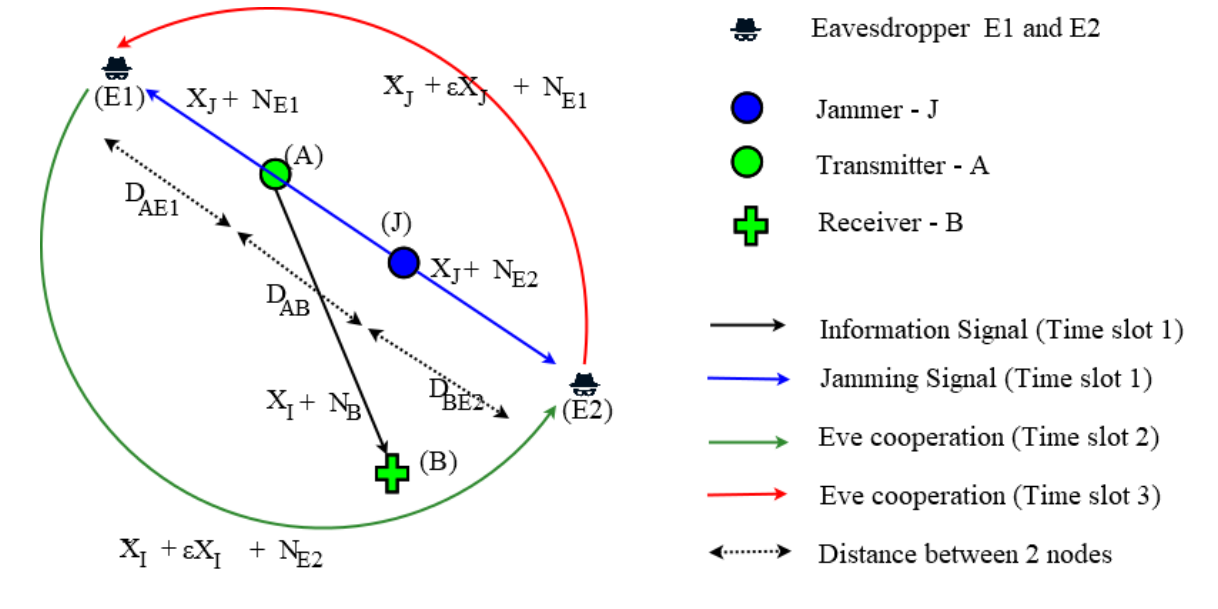
Figure 1. Cooperative eavesdroppers in the system model. In this model, the jamming signal does not interfere with legiti- mate